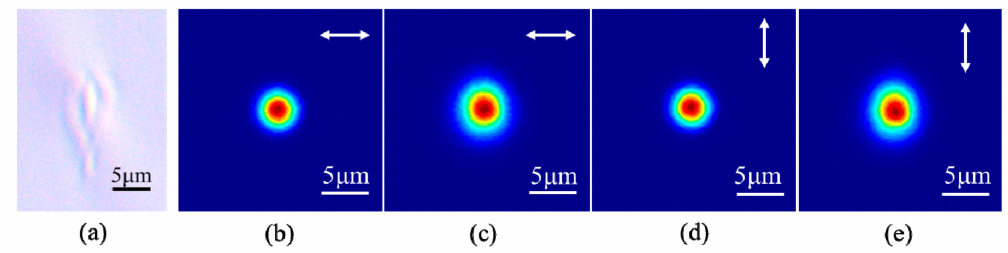
Figure 2. Optical micrograph and mode distributions of a fabricated straight waveguide. ( a ) Micrograph of the cross section of the waveguide. ( b ) Mode of the fiber in H polarization; ( c ) mode of the waveguide in H polarization; ( d ) mode of the fiber in V polarization; ( e ) mode of the waveguide in V polarization. The wavelength of the injected CW laser is 785 nm.